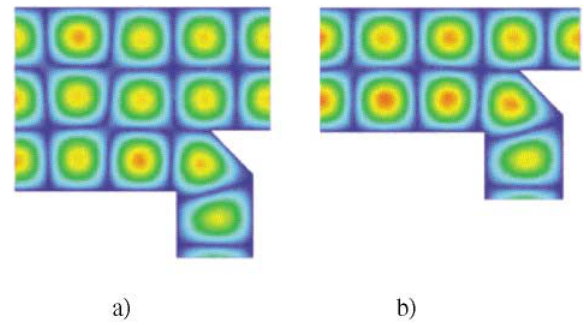
FIG. 10. (Color) Tap-offs utilizing the idea of achieving frac- tional power division by deflecting a lobe of a TE n 0 field pattern. This requires converting to TE 30 before the first of a structure triplet.